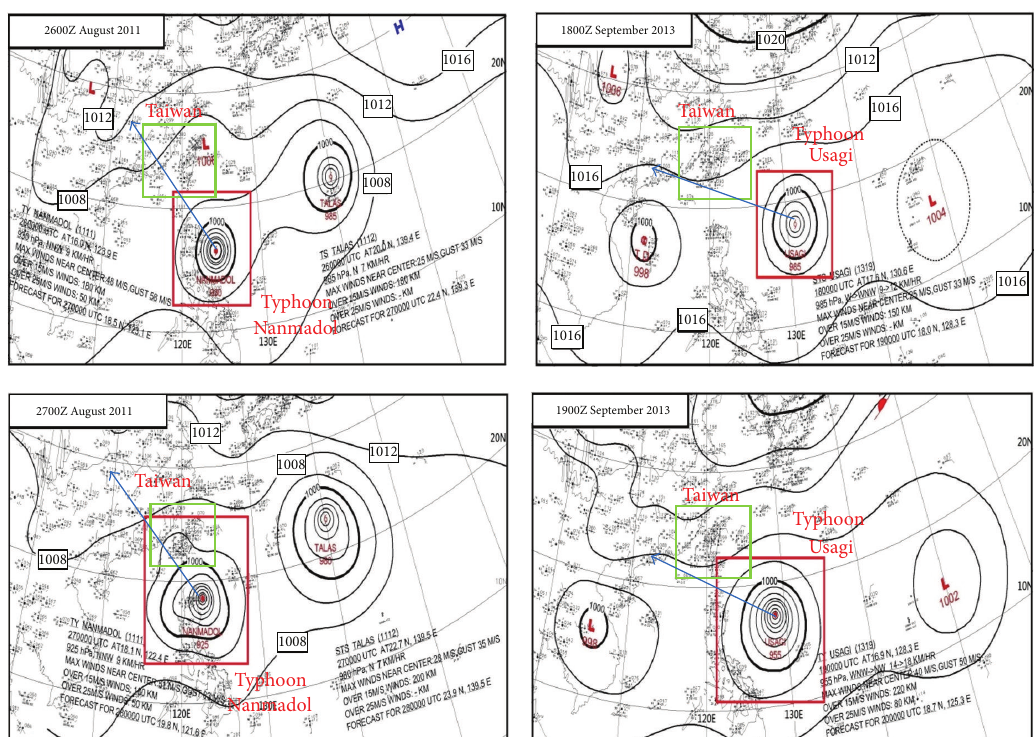
Figure 4: Surface weather charts for typhoons Nanmadol and Usagi (data from Taiwan